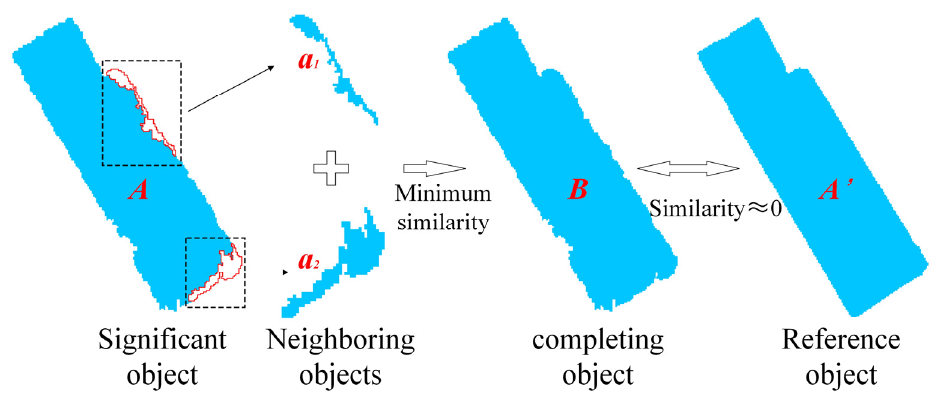
Figure 6. Process of significant object completion. A , B and A (cid:48) represent the identified significant object, merged completing object, and reference object, respectively, while a 1 and a 2 are neighboring objects of the identified significant object. The similarity in the figure is calculated from formula 5.